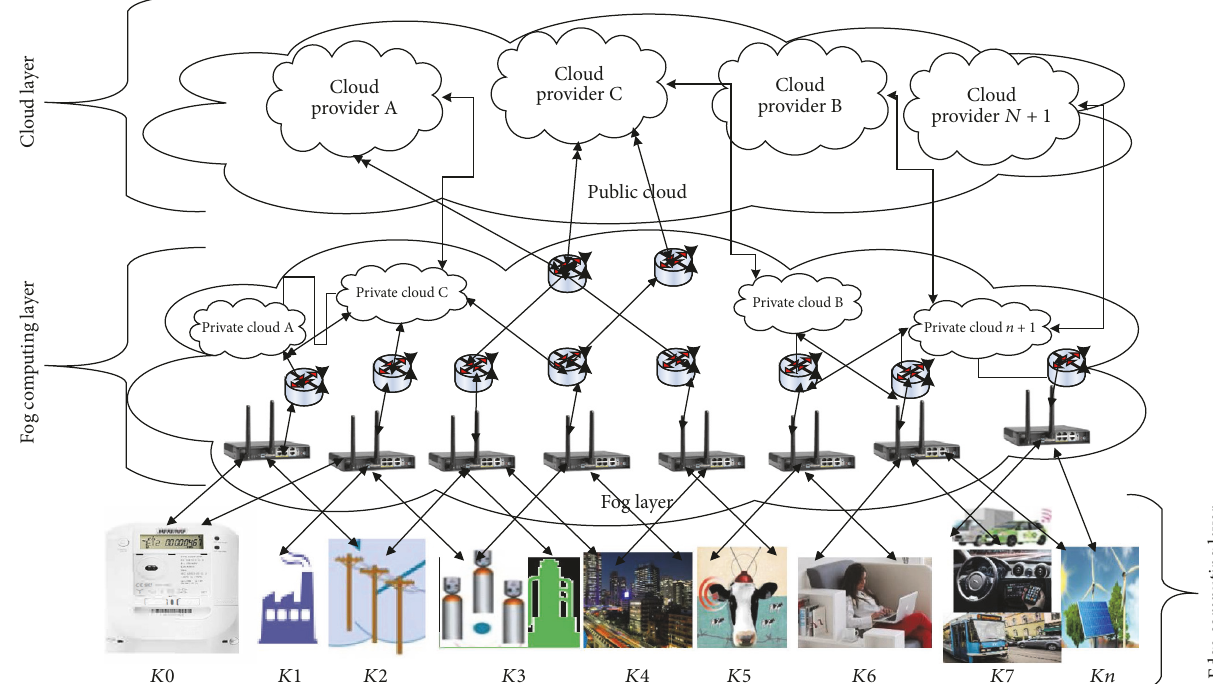
Figure 1: A conceptual framework for Fog distributed data processing (the author’s model with Visio